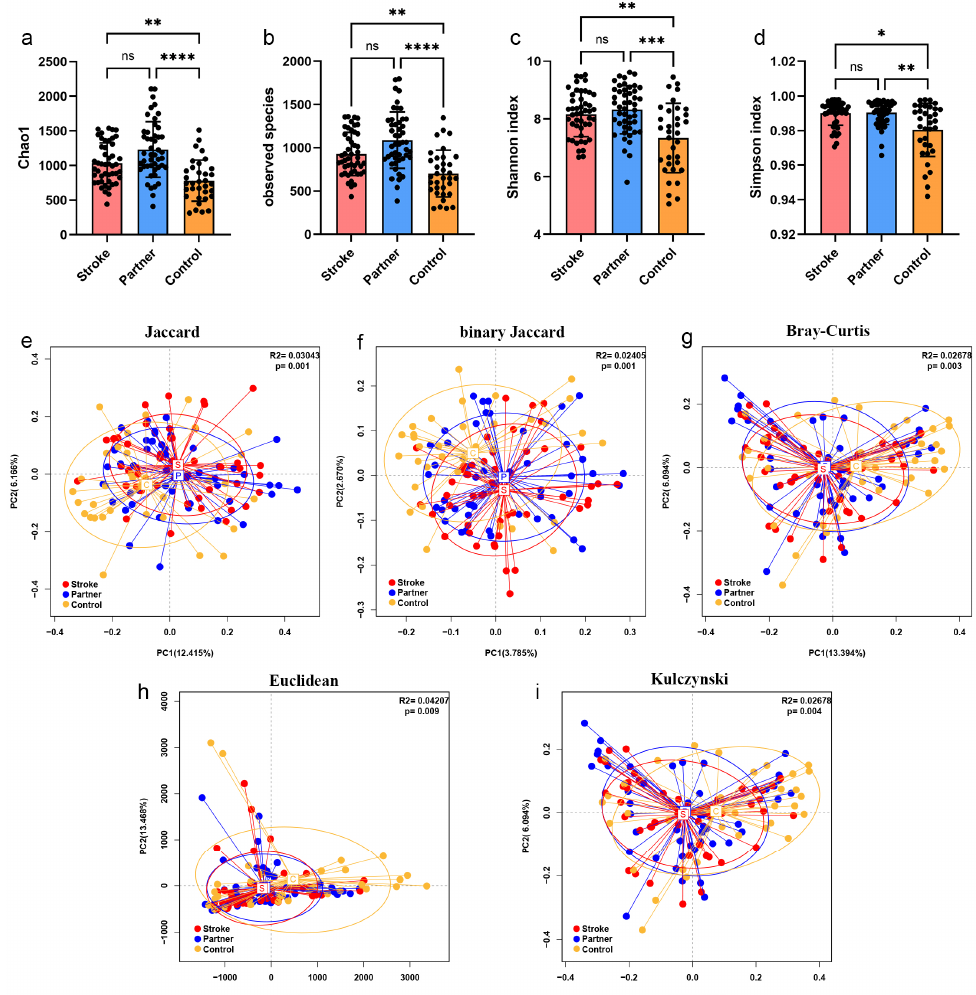
Figure 2. Comparisons of microbial alpha- and beta-diversity between the three groups. ( a – d ) Comparison of alpha-diversity index Chao1, observed species, Shannon index and Simpson index between the three groups. The Shannon and Simpson indexes indicate the number and distribution of microbial species in a sample. The observed species index indicates the number of species in the sample. The Chao1 index indicates community richness. ( e – i ) Comparison of beta-diversity index abund Jaccard, binary Jaccard, Bray-Curtis, Euclidean, and Kulczynski index between the three groups. A smaller distance between two samples indicates a higher similarity. As a dimensionality reduction method, principal-coordinate analysis (PCoA) was used to describe the relationships among samples based on the distance matrix and visualize the unsupervised grouping pattern of the microbiome. Data were expressed as mean ± SD, * p < 0.05, ** p < 0.01, *** p < 0.001, **** p < 0.0001. ns, no significance.